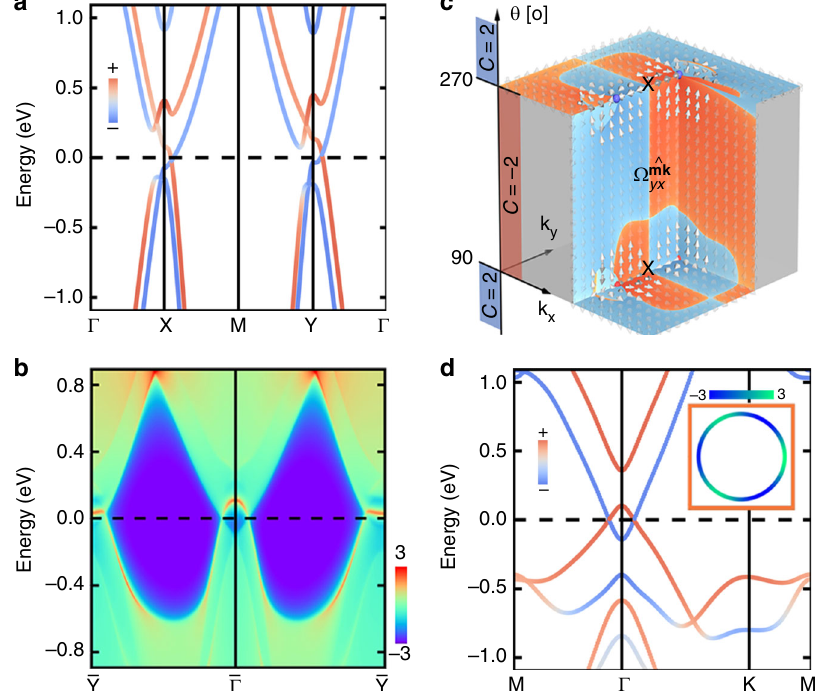
Fig. 4 Electronic properties of mixed topological semimetals. a Spin-resolved band structure and ( b ) energy dispersion of a fi nite ribbon, where the localization at the edge is indicated by colors ranging from blue (weak) to red (strong), of the TlSe monolayer with an in-plane exchange fi eld of magnitude B = 0.5 eV. c Around the X point, for example, the emergence of nodal points with opposite topological charge (red and blue balls) for reversed in-plane directions θ of the magnetization imprints characteristic features on the phase-space distribution of the Berry curvature fi eld Ω ¼ ð(cid:3) Ω indicated by the arrows. A logarithmic color scale from blue (negative) to red (positive) is used to illustrate the mixed Berry curvature Ω phase space of k and θ . d Spin-resolved band structure of one-layer Na 3 Bi with an exchange fi eld of magnitude B = 0.5 eV applied perpendicular to the fi lm. Owing to the mirror symmetry of the system, the band crossings around Γ form a mixed nodal line in momentum space, which disperses as illustrated in the inset, where colors indicate energy differences between the crossing points and the Fermi level in